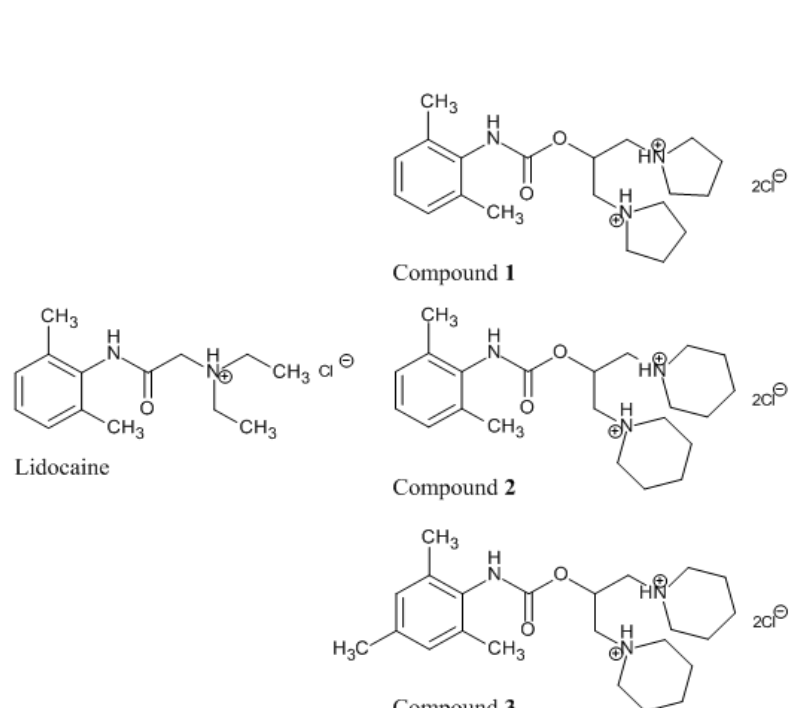
Figure 1. Chemical structure of lidocaine (lidocainium chloride) and dibasic esters of phenylcarbamic acid under the